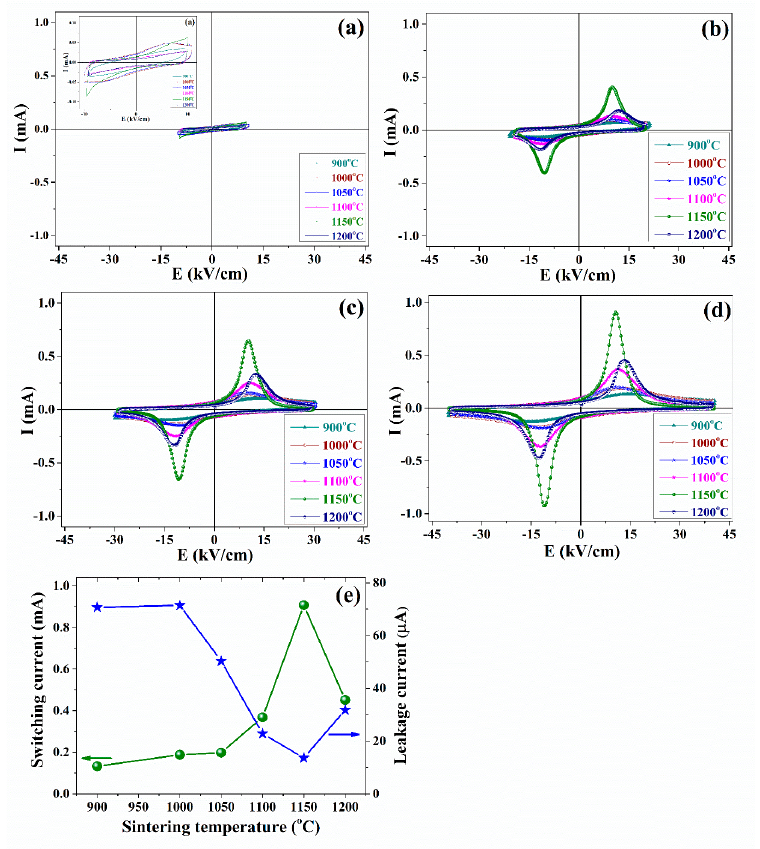
Figure 4. Current vs. electric field (I-E) curves for the microwave sintered PLZT 8/60/40 ceramics measured at different electric fields ( a ) 10 kV/cm, ( b ) 20 kV/cm, ( c ) 30 kV/cm and ( d ) 40 kV/cm, 1 Hz and 25 °C. ( e ) Switching current (corresponding to current peaks) and leakage current (current at E max ) vs. sintering temperature graphs for microwave sintered PLZT ceramics, measured at 40 kV/cm. The inset of Figure ( a ) shows the zoomed-in image of the I-E